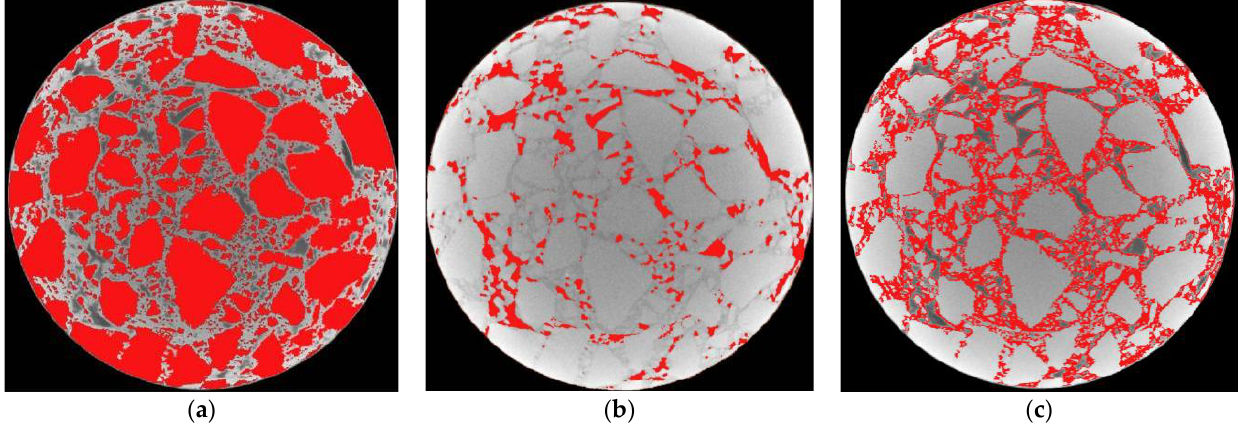
Figure 12. Validation of the separation effect of various components. ( a ) Aggregates. ( b ) Voids. ( c ) Asphalt